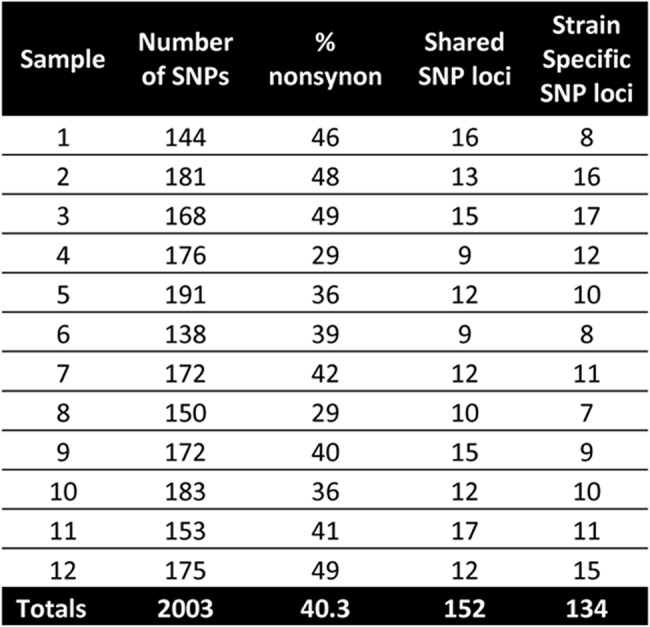
Annotation of the number of single nucleotide polymorphisms (SNP), percentage of SNPs which were nonsyonymous, number of shared SNP loci among study isolates (1 through 12) and number of strain specific SNPs among study isolates.